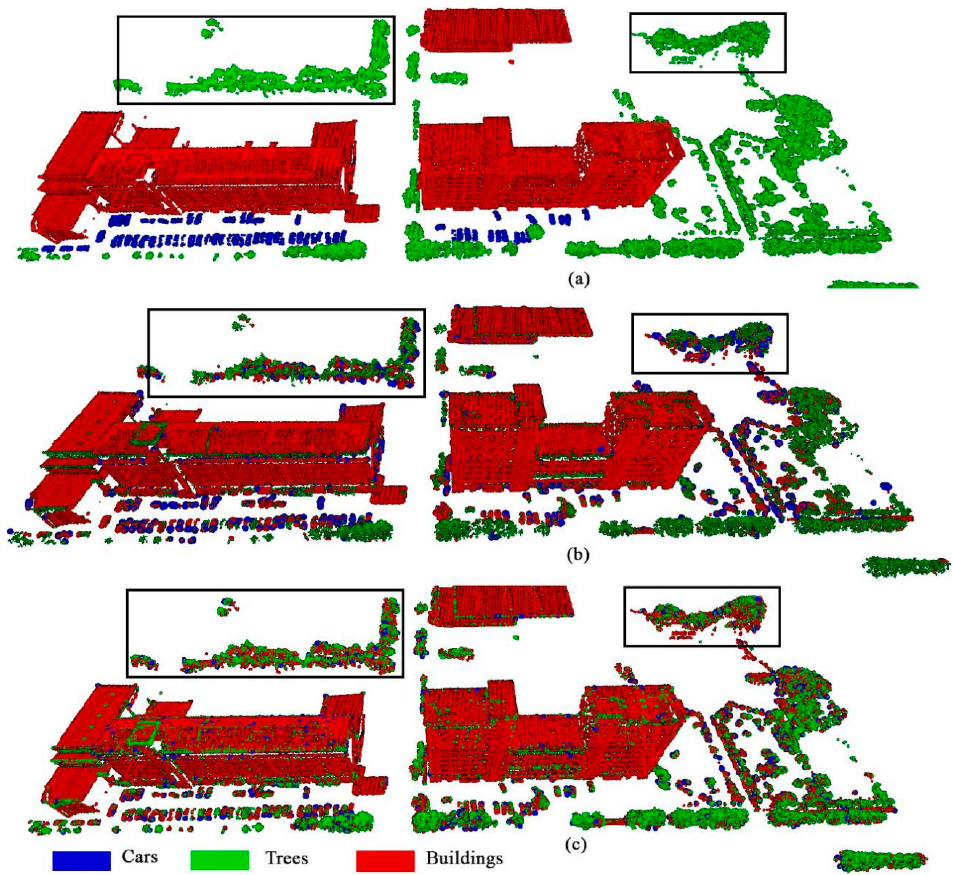
Figure 4. Classification results of Scene2. ( a ) Ground truth; ( b ) our method; ( c ) RICA-SVM.